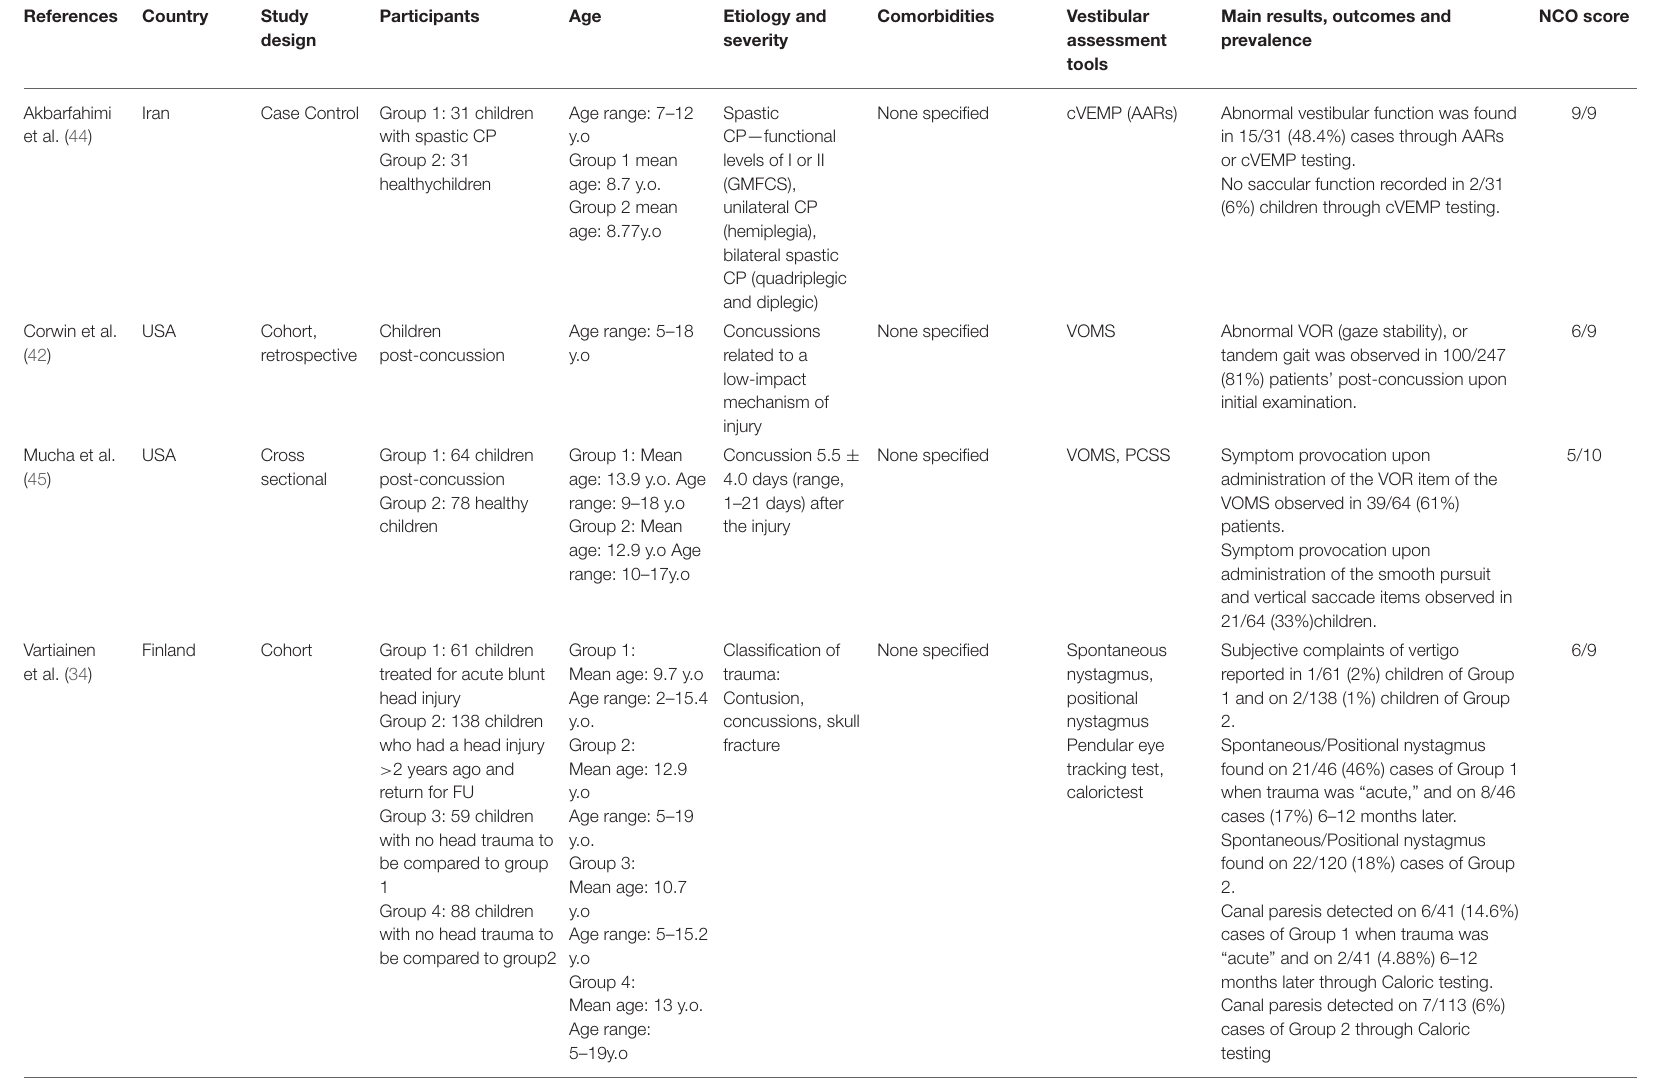
TABLE 3 | Studies addressing central neurological conditions (Cerebral palsy and traumatic brain